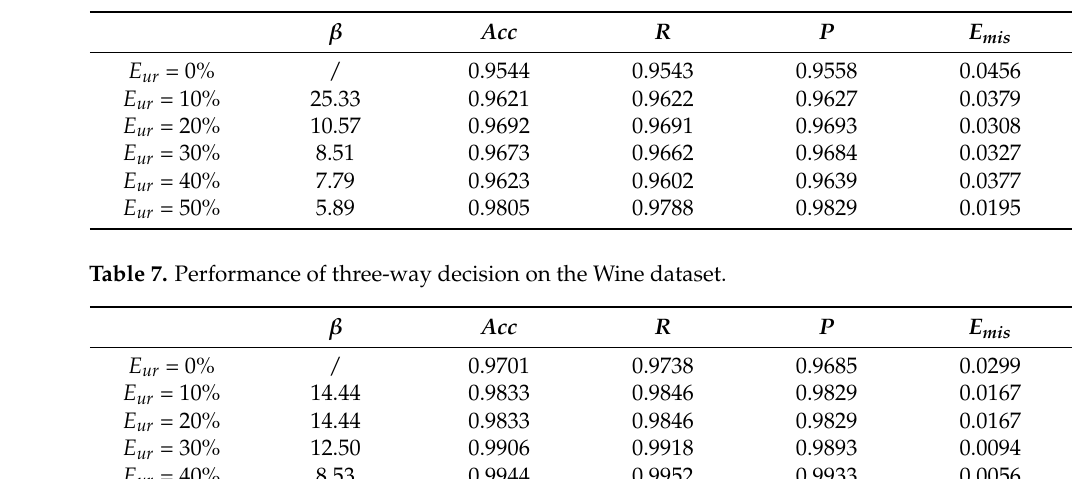
Table 6. Performance of three-way decision on the Seeds dataset.